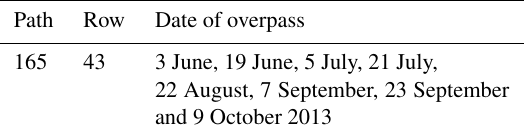
Table 3. Details of Landsat-8 data used in the study. Path